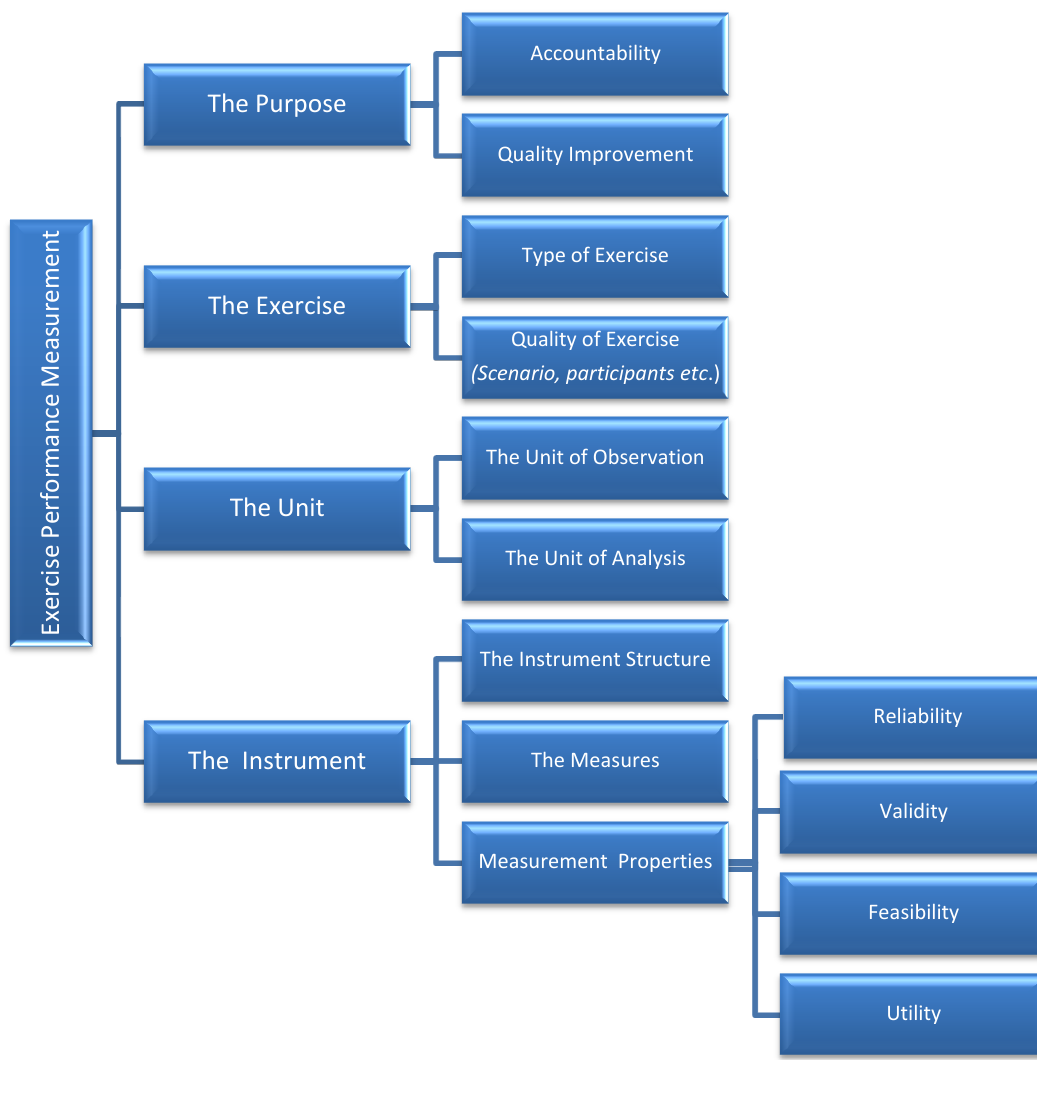
Figure 1. Conceptual model of exercise performance